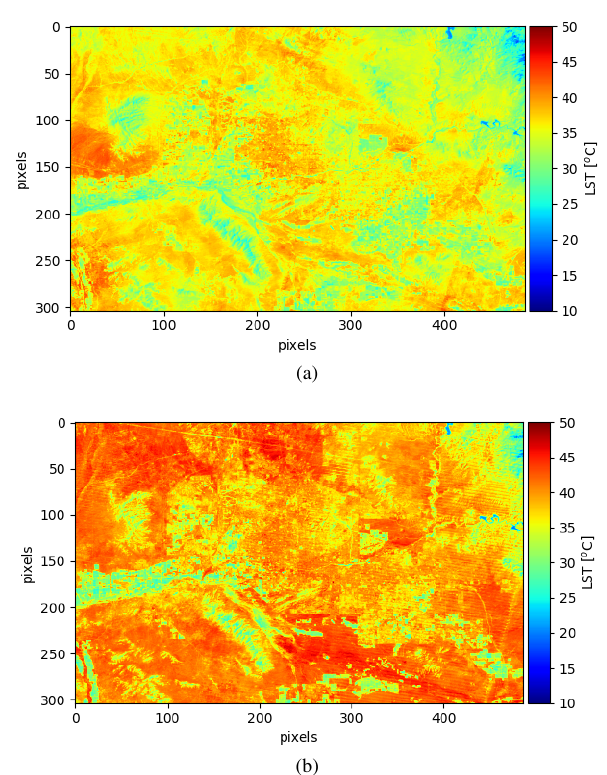
Figure 2: LST 1992 (a) and 2011 (b) obtained through CE for the considered ROI.